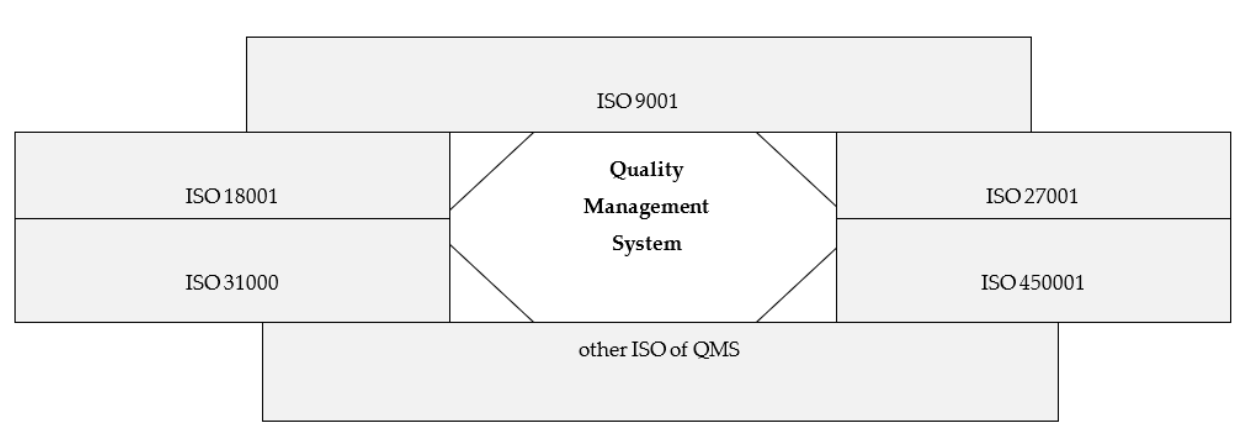
Figure 2. Author’s recommendations for energy companies listed on the Polish stock exchange in the area of reporting QMS information. Source: the authors.